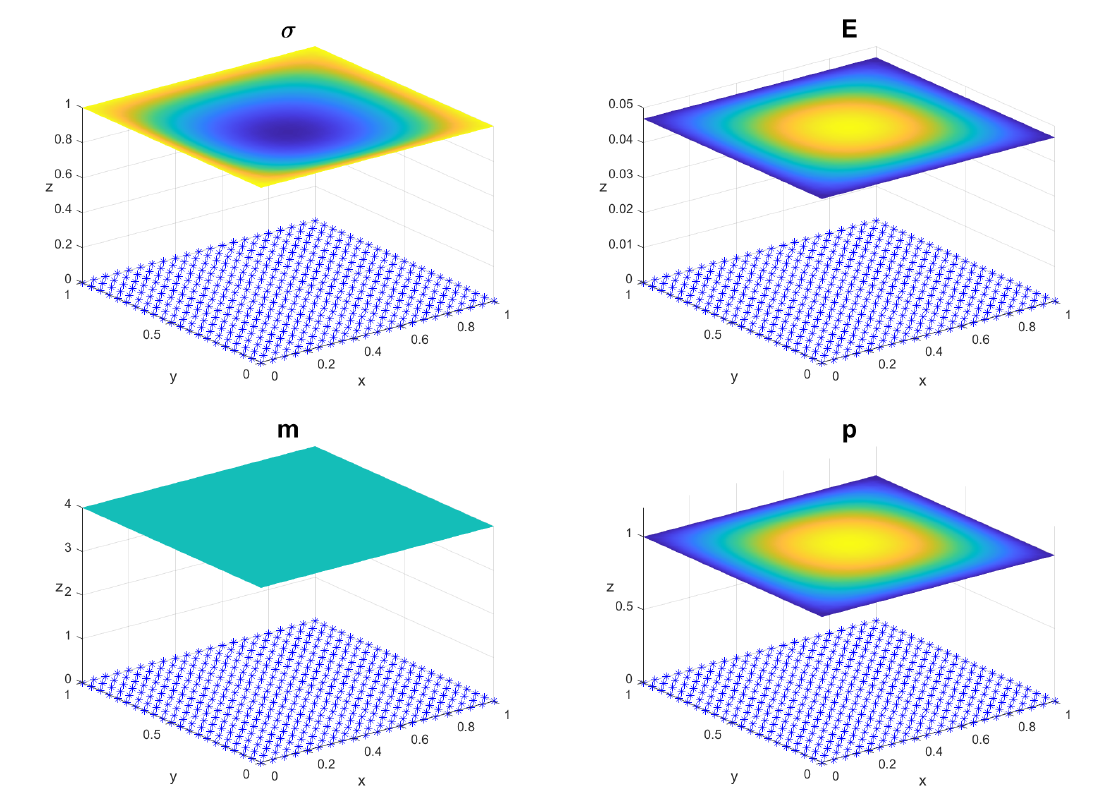
Figure 3. Graphs of the functions: σ , E , m and p for t = 5